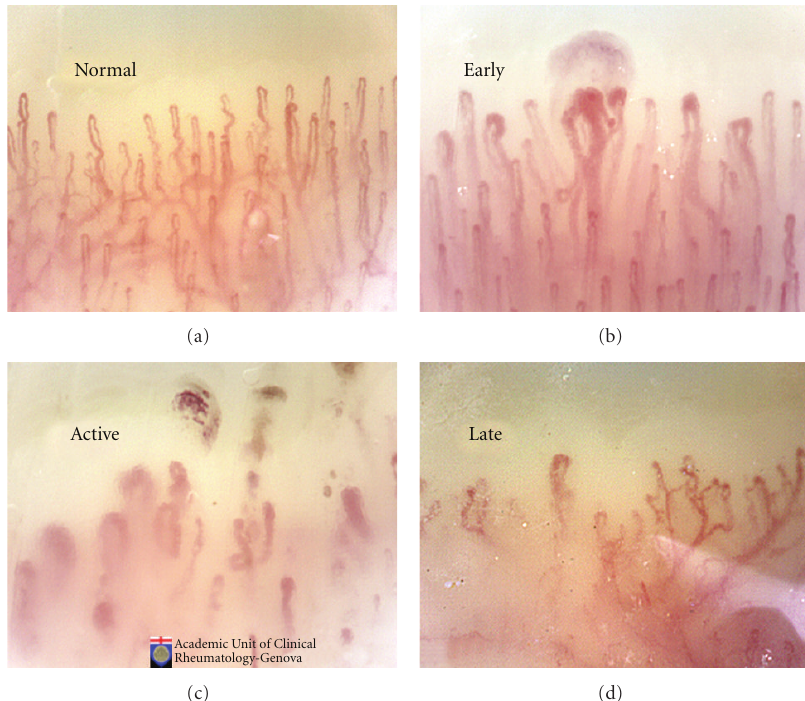
Figure 2: The morphological capillary abnormalities in SSc have been classified in 3 validated patterns (early, active, and late) of microangiopathy by NVC